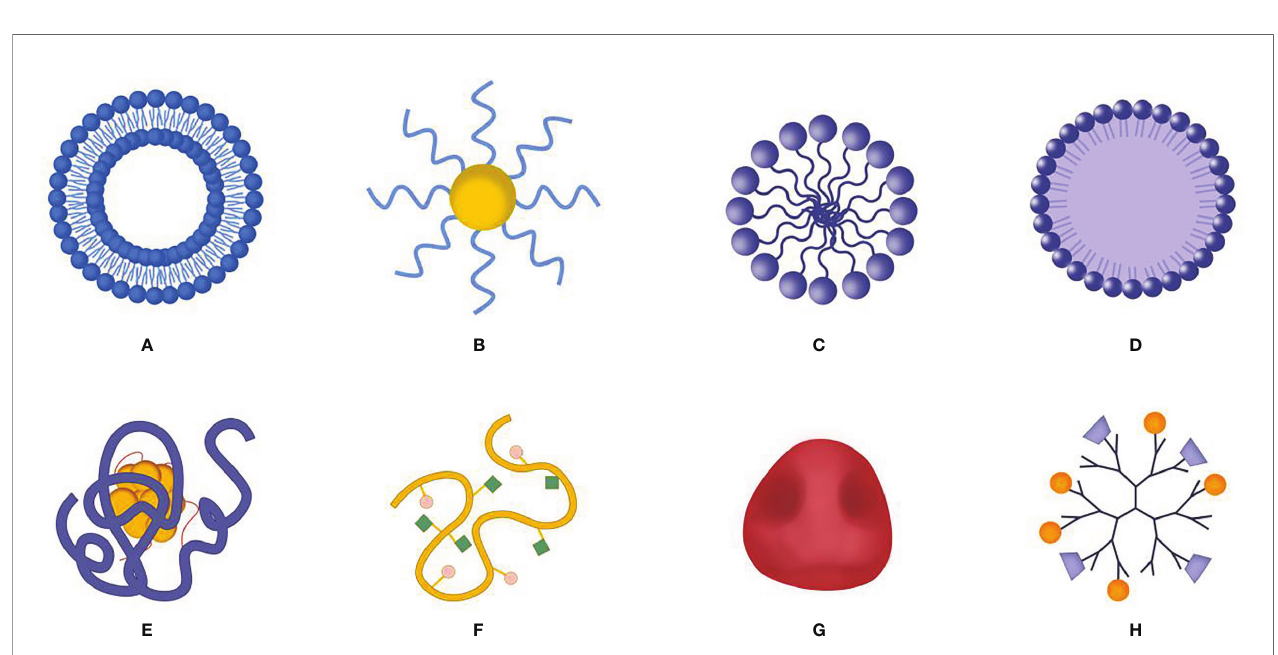
FIGURE 4 | Schematic diagram of nano delivery system carrier. (A) Liposome, (B) gold nanoparticle, (C) polymeric micelle, (D) solid lipid nanoparticles, (E) protein and molecular complex, (F) polymer-molecular conjugates, (G) bio fi lm bionic nanoparticles, (H)